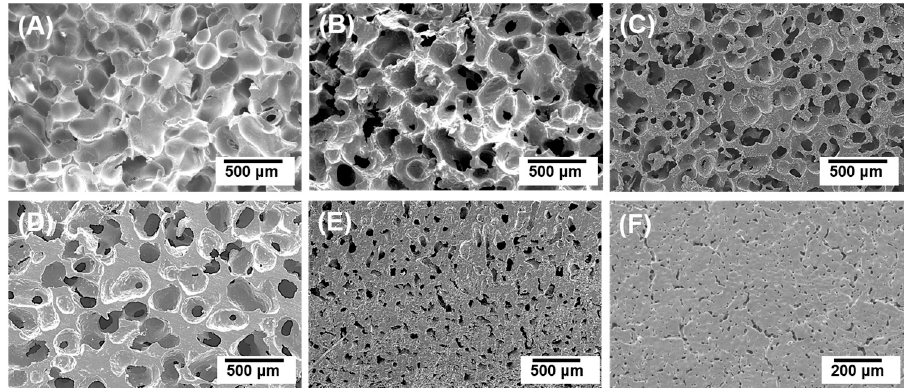
Figure 3. Typical scanning electron microscopy (SEM) images of porous HA scaffolds with initial HA